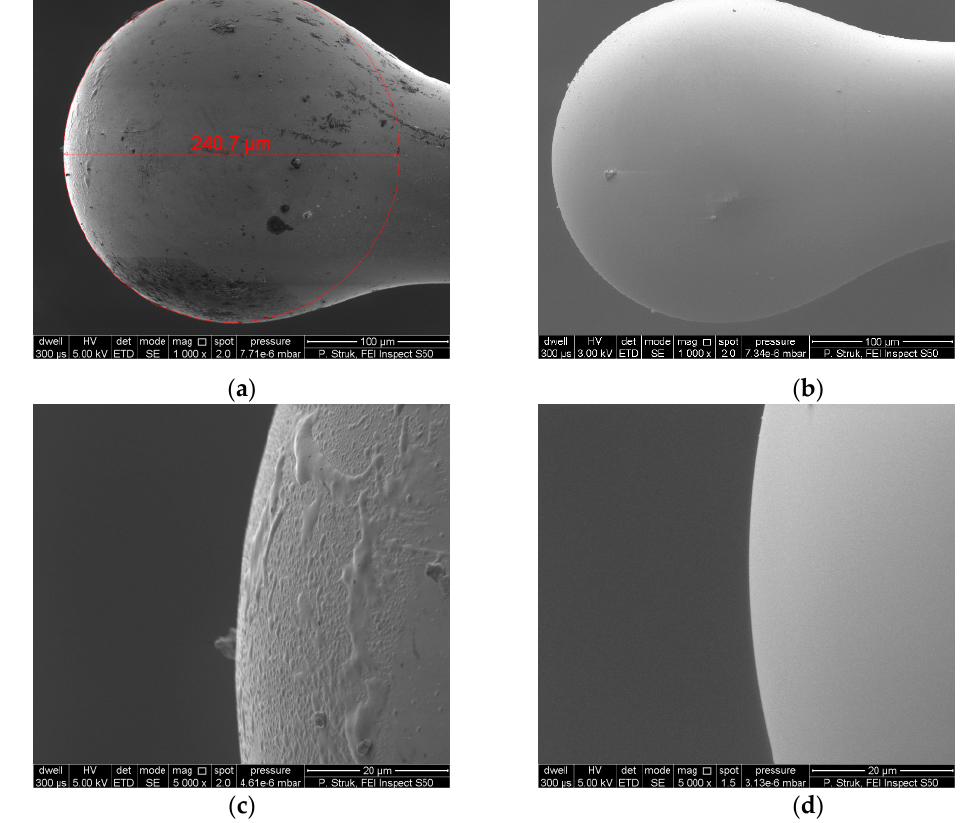
Figure 3. SEM images of optical fiber microsphere: ( a ) the microsphere with 200 nm ZnO coating, ( b ) the microsphere without ZnO coating, ( c ) surface topography on the front side of the microsphere with 200 nm ZnO coating, ( d ) surface topography on the front side of the microsphere without ZnO coating.